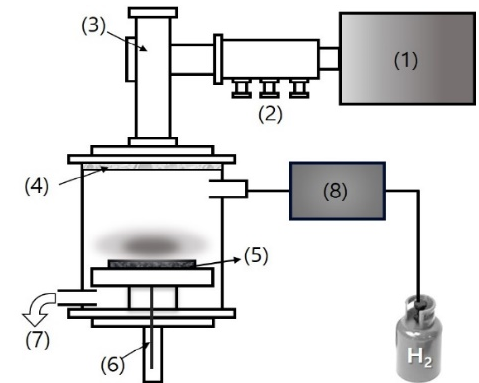
Figure 1. Schematic of the microwave plasma-enhanced chemical vapor deposition (MPECVD) system: (1) microwave remote power head; (2) three-stub tuner; (3) plasma applicator; (4) microwave window; (5) graphite substrate; (6) manipulating heater stage; (7) pumping system; and (8) mass flow controller system. Table 1. Experimental conditions for H 2 plasma treatment using the microwave plasma-enhanced chemical vapor deposition (MPECVD) system.